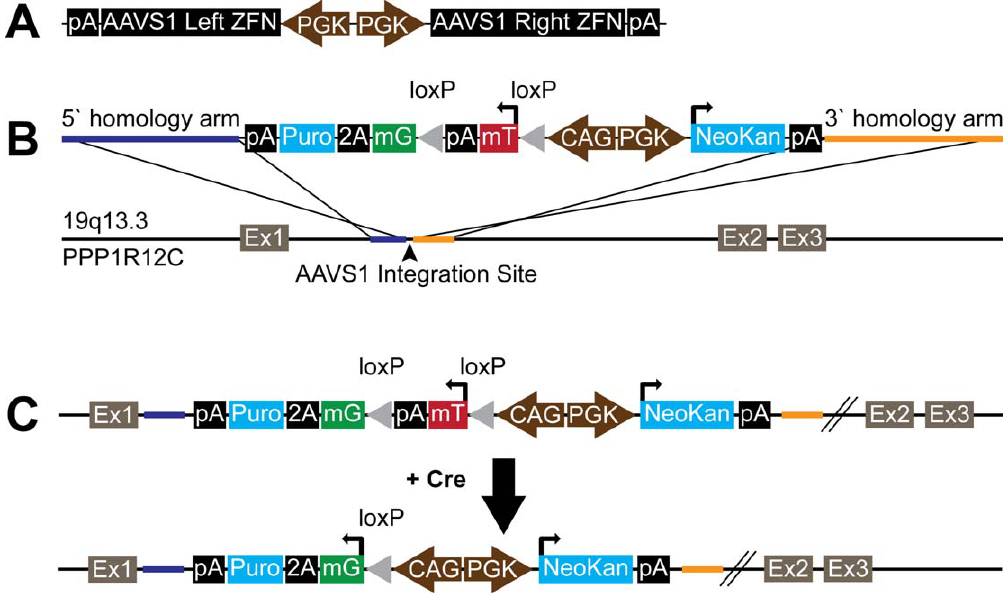
Figure 1. Transgene plasmid construction. ( A ) pAAVS1ZFN vector diagram showing two reverse orientation human PGK promoters driving the left and right AAVS1 zinc finger nucleases (ZFNs). ( B ) pZDonor-mTmG-2a-Puro vector diagram and the AAVS1 genomic integration site on chromosome 19 in the first intron of the PPP1R12C gene. The PGKNeoKan cassette enables selection of cells with stable transgene integration and the CAG-mTmG-2a-Puro selectable ‘‘stoplight’’ cassette allows for visual and antibiotic selection of cells that have been recombined by Cre recombinase. Yellow and blue colored bars represent , 800 bp stretches of sequence homologous to either side of the AAVS1 target locus. ( C ) In coordination with the AAVS1 ZFNs, the mTmG-2a-Puro transgene was integrated into the AAVS1 site by homologous recombination. Cre mediated recombination of LoxP sites removes the tdTomato expression cassette and results in eGFP-2a-Puro expression. Abbreviations: pA = bovine growth hormone polyadenylation signal, mT = myristoylated tdTomato, mG = myristoylated eGFP, NeoKan = neomycin/kanamicin resistance, Puro = puromycin resistance, loxP = Cre recombinase locus of chromosomal crossover, Ex = exon.